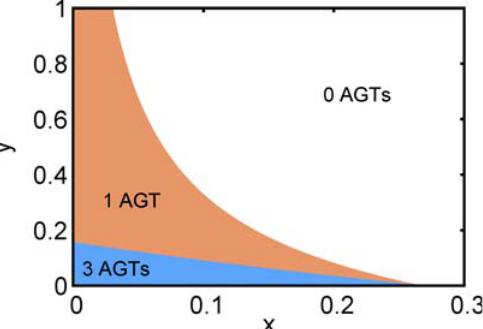
Figure 2. The Anomaly Zone for the Four-Taxon Asymmetric Species Tree Topology Branch lengths x and y (see Figure 1) are measured in coalescent time